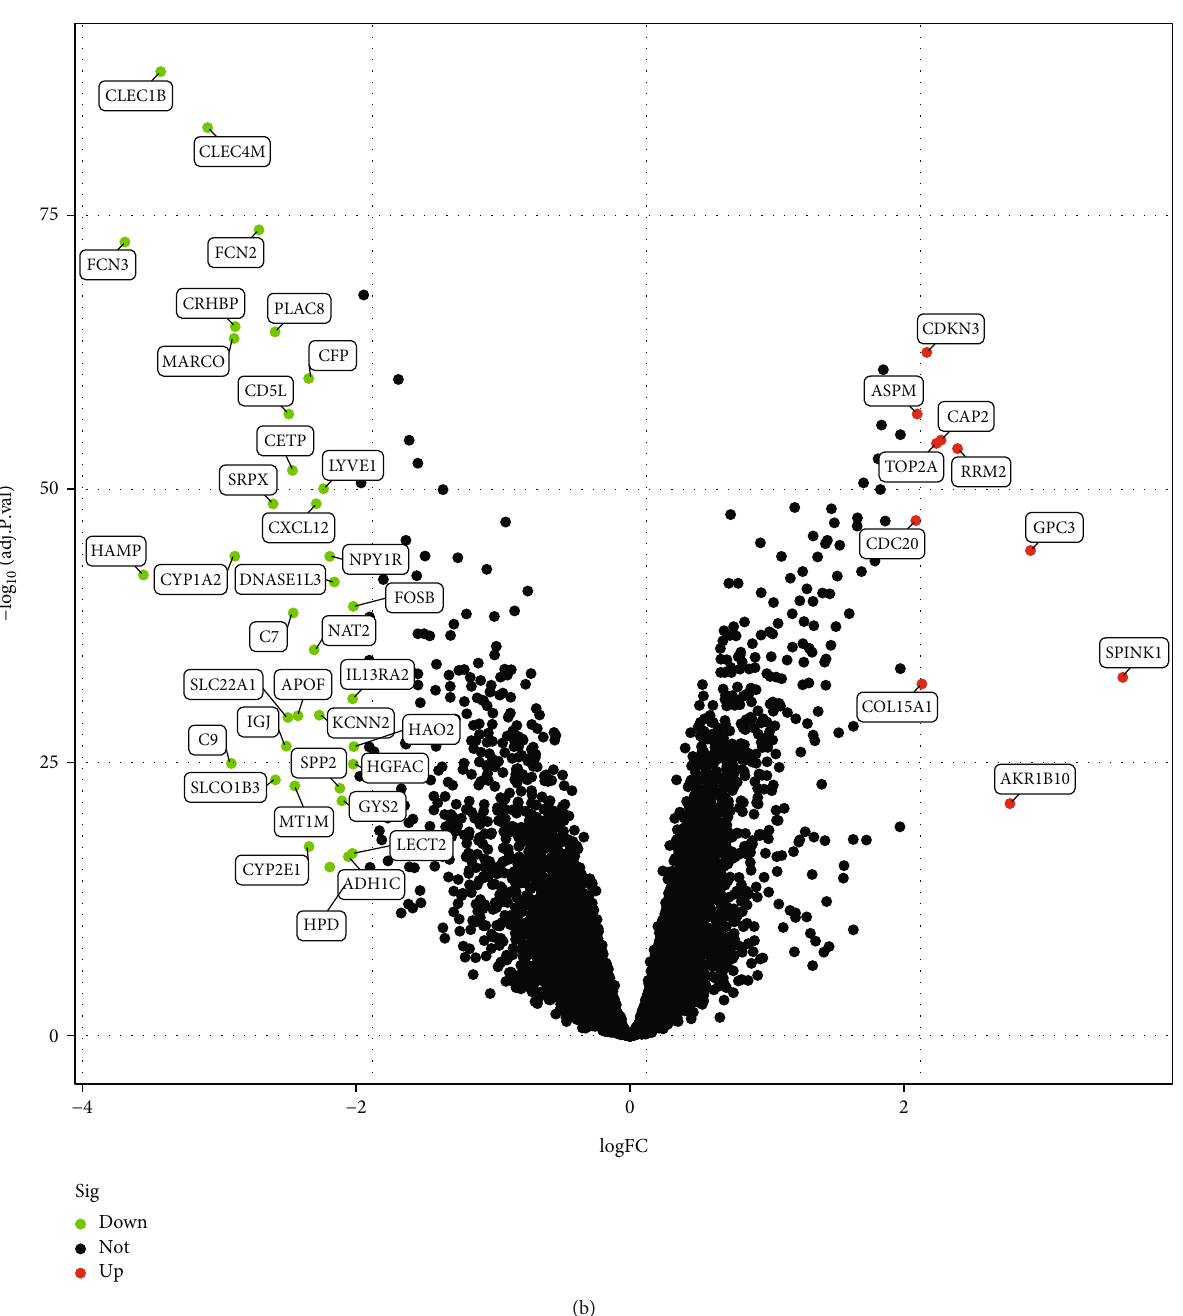
Figure 1: Di ff erentially expressed genes (DEGs) identi fi ed between HCC and control samples. (a) Heatmap of DEG distribution and (b) volcano plots of DEG